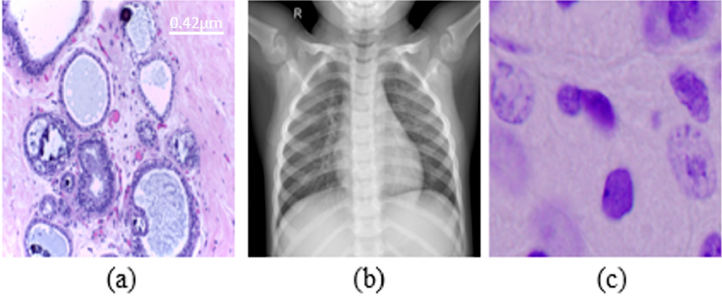
Figure 1. Examples from datasets were used. ( a ) Histopathology (scale bar - 0.42 μ m), ( b ) chest X-rays, ( c ) nuclei cells. In Tables 2 and 3, the results accuracy percentage for X-rays and histopathology im- ages are presented, respectively. Table 2. Image quality and accuracy in histopathological images under attacks (in %).